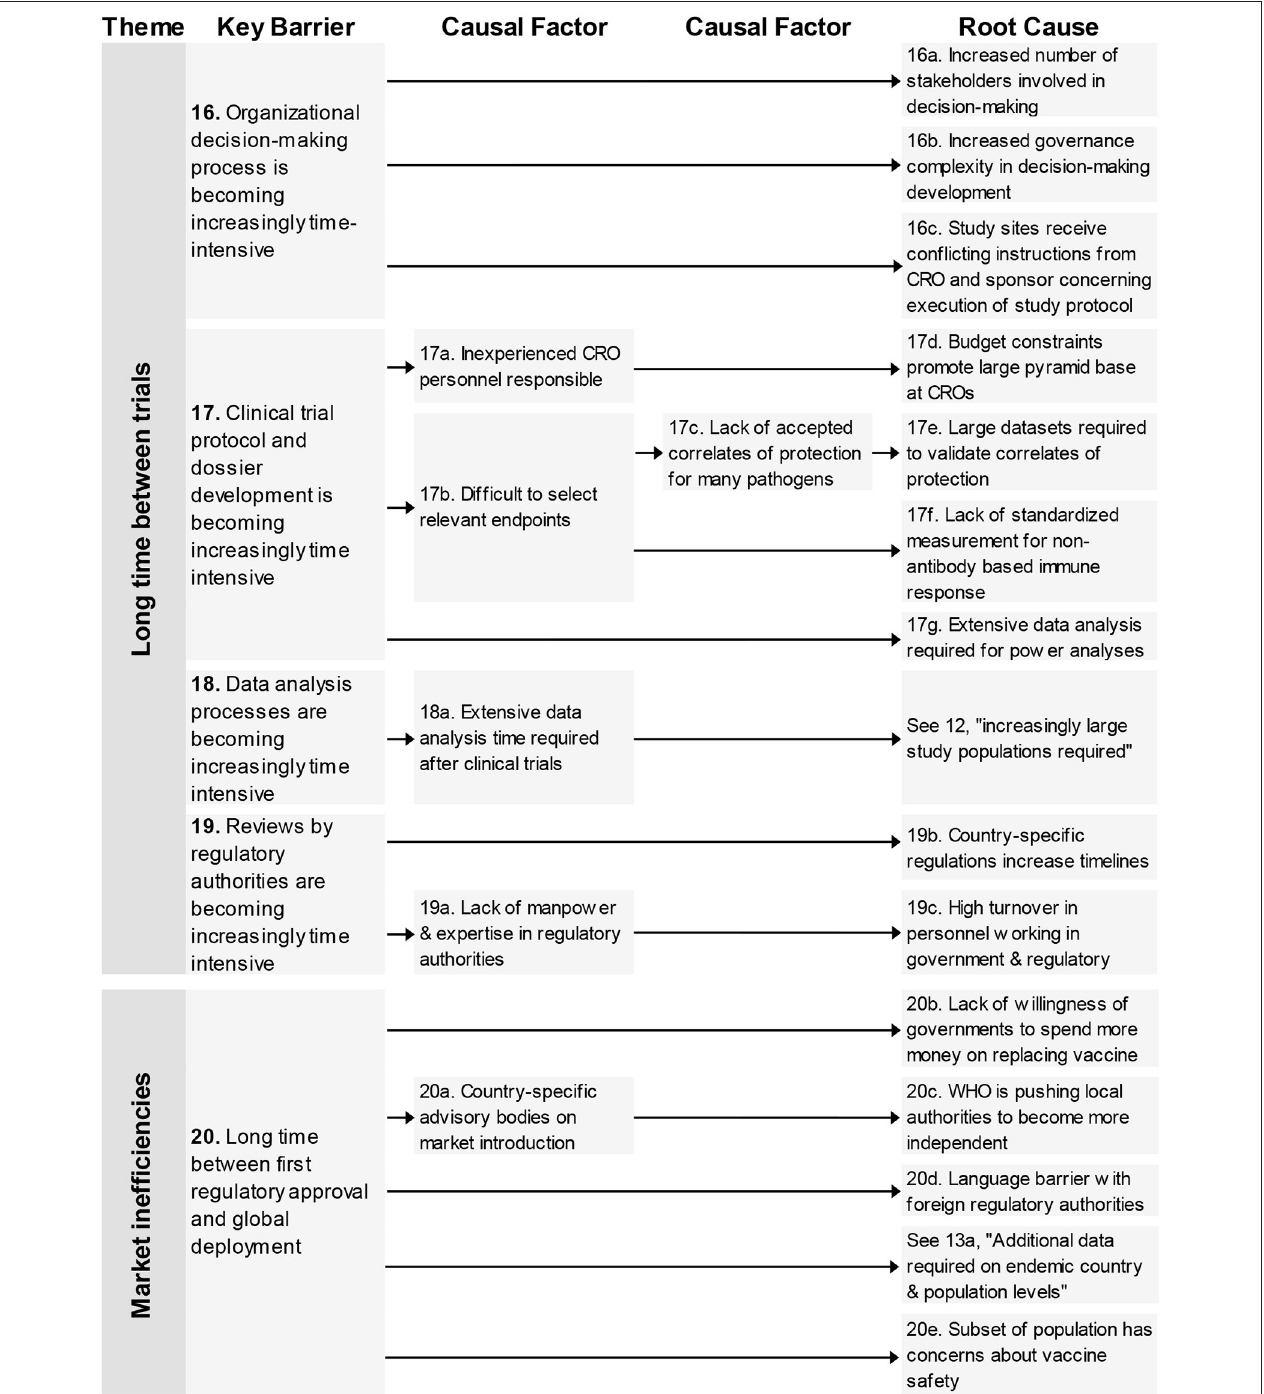
FIGURE 5 | Root-cause analysis of the themes “Long time between trials” and “Market inefficiencies.” Columns are causally structured. (Left) key barriers are listed that are caused by causal factors (middle), which in turn find their origin in root causes (right). Long time between trials (Figure 5).